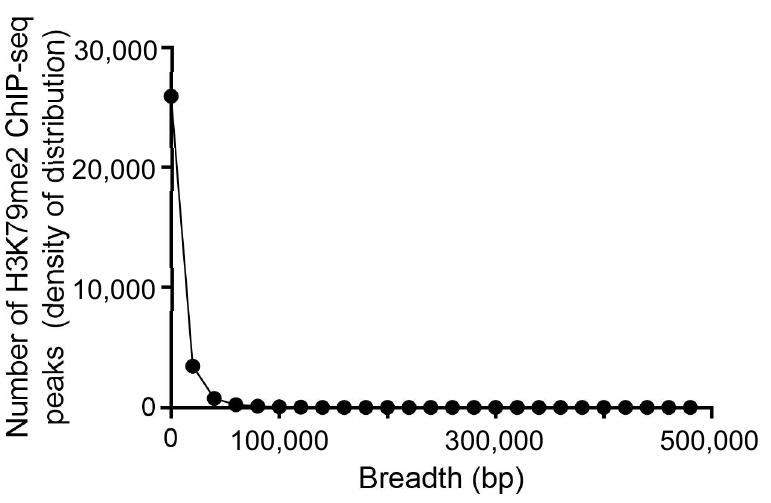
Figure 1. Density distribution of H3K79me2 peaks in MOLM-13 cells. The panel shows the density distribution of H3K79me2 peaks identified by the MACS2 peak caller.